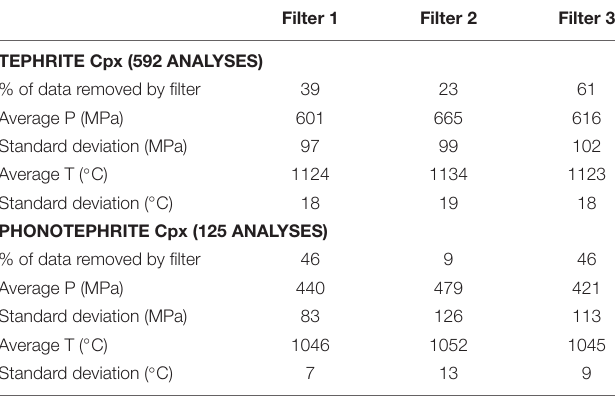
TABLE 3 | Overview of P-T data for clinopyroxene rims and host melt. Filter 1 Filter 2 Filter